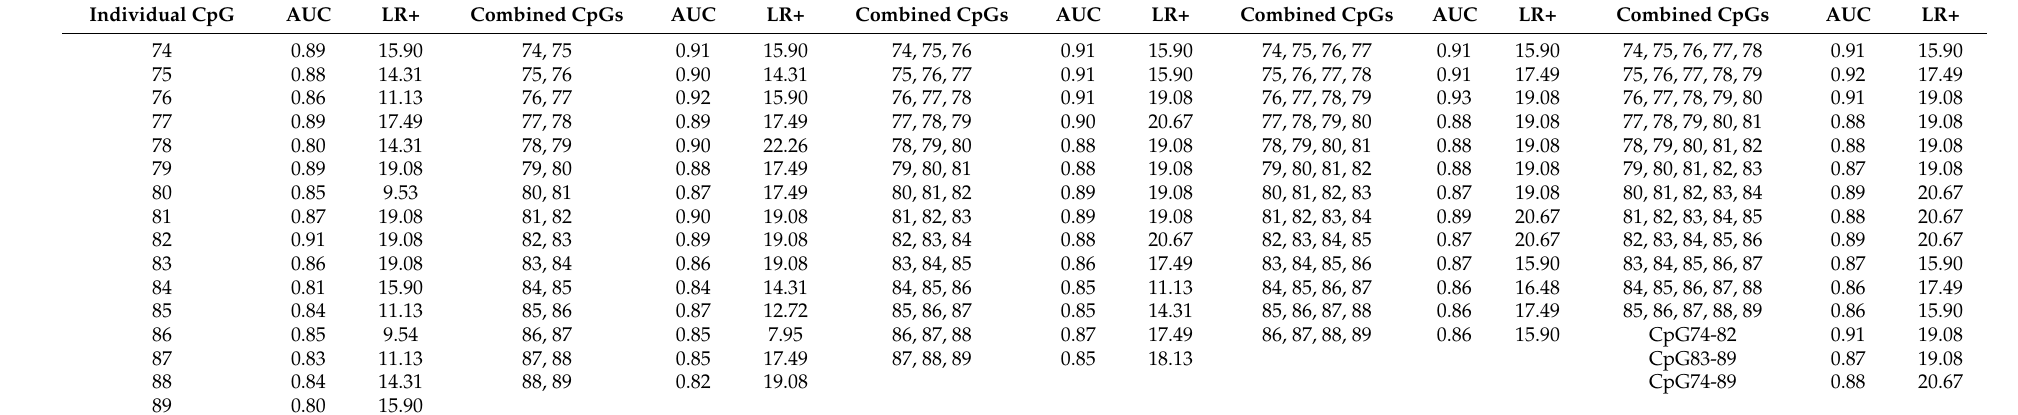
Table 2. AUC value and LR+ calculated by ROC